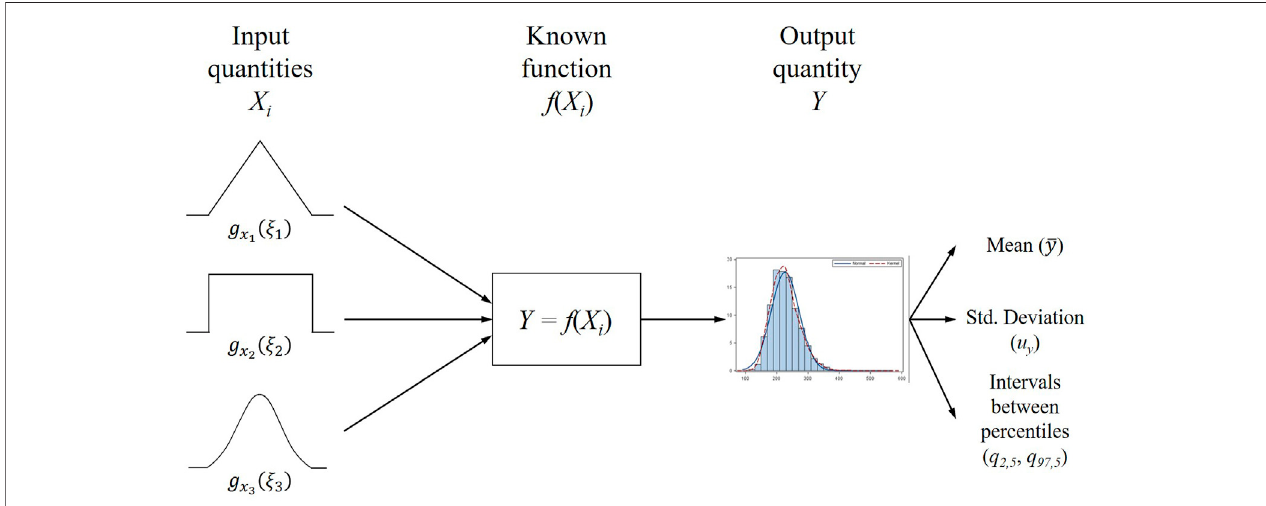
FIGURE 2 | Schematic representation of the process followed toobtain a general numerical approximation ofthe output quantity distribution with the Monte Carlo simulation method.